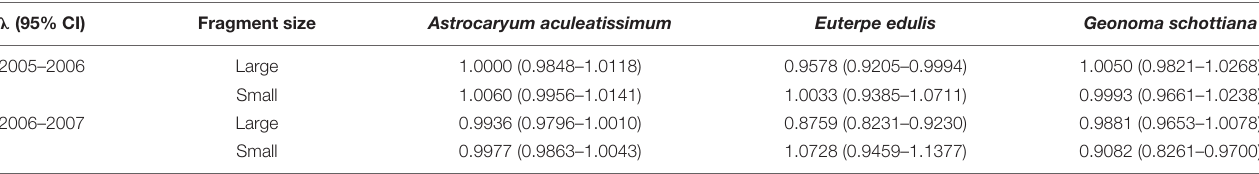
TABLE 2 | Deterministic asymptotic growth rate ( λ ) and 95% confidence intervals (95% CI) for Astrocaryum aculeatissimum , Euterpe edulis , and Geonoma schottiana in three small forest fragments and two large forest fragments in the Atlantic Rain Forest.